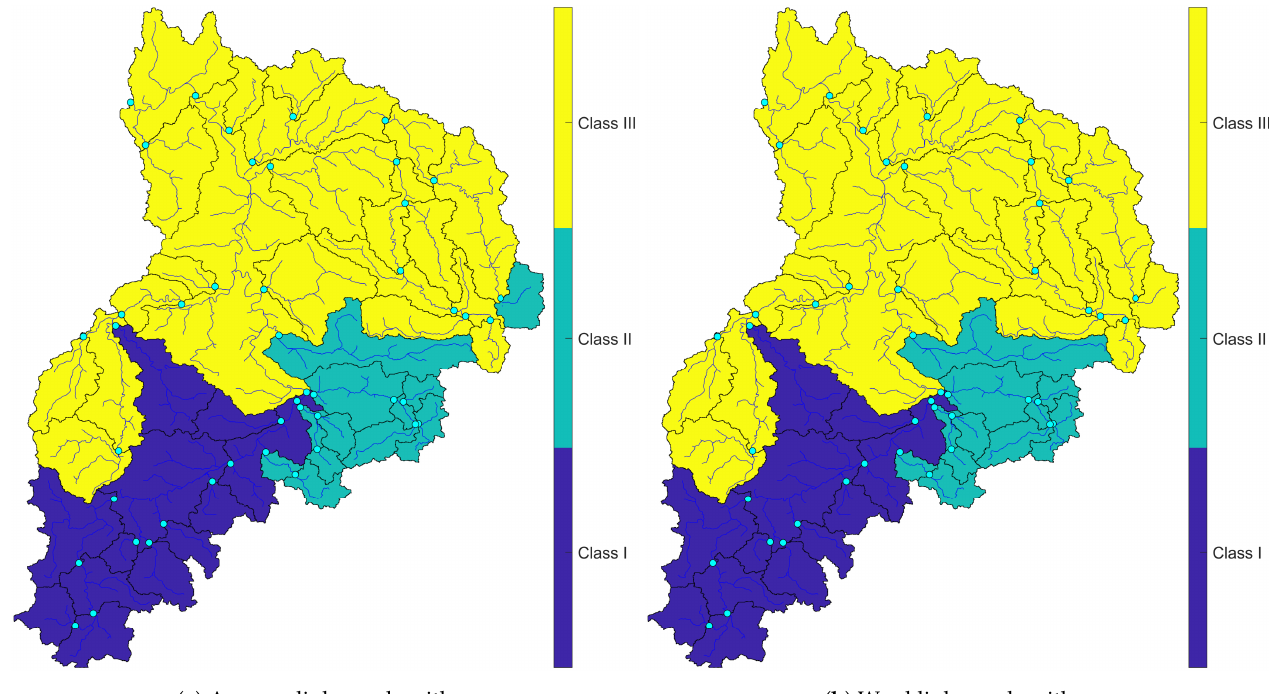
Figure 10. Clustering the simultaneous occurrences of the biggest flood events using Kendall